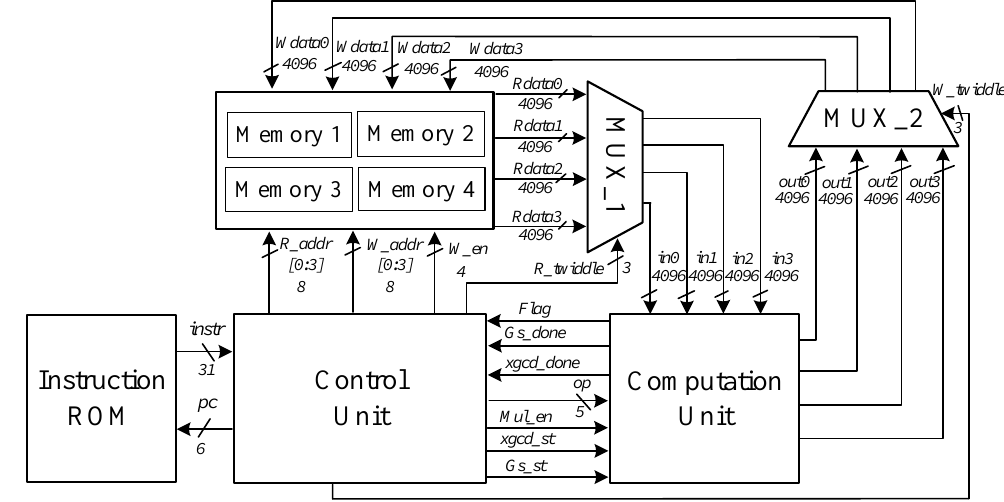
Figure 10: Proposed high-level architecture of squaring in the class group.